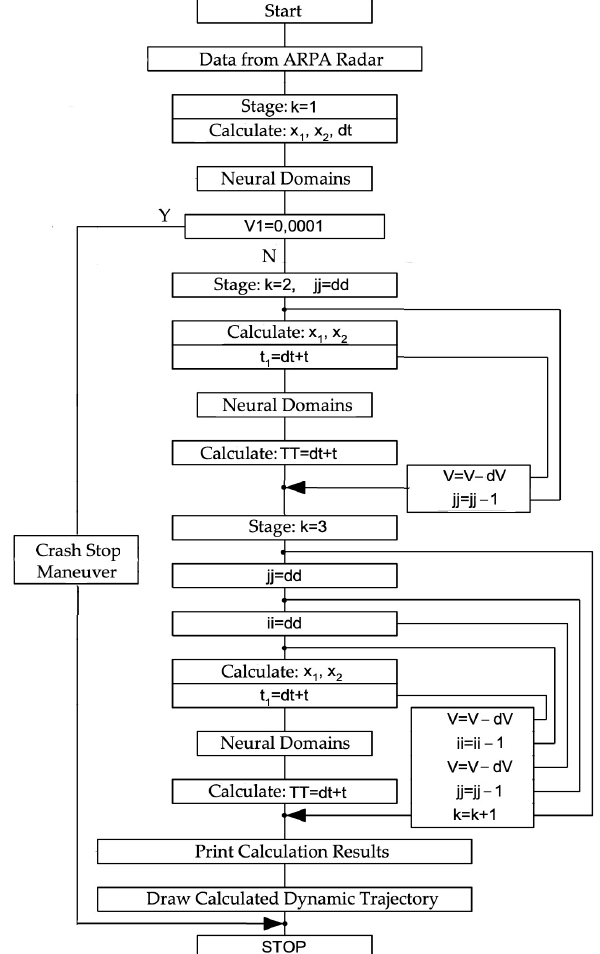
Figure 10. Flow chart of the DT algorithm for calculating the ship’s safe dynamic trajectory in a collision situation using marine environment radar remote sensing data.